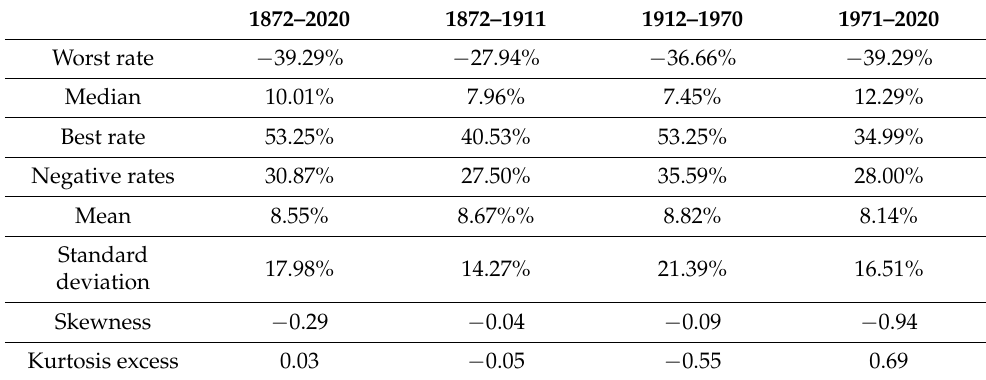
Table 5. Annual real rates of linear return, 1872–2020, three